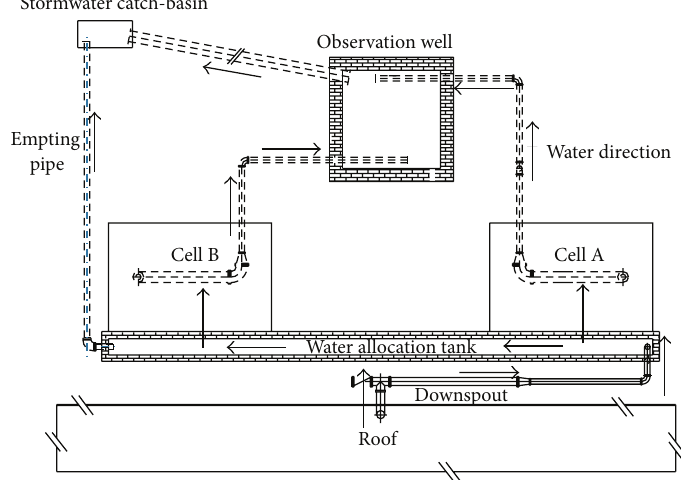
Figure 1: Plan of the bioretention study area (not to scale).